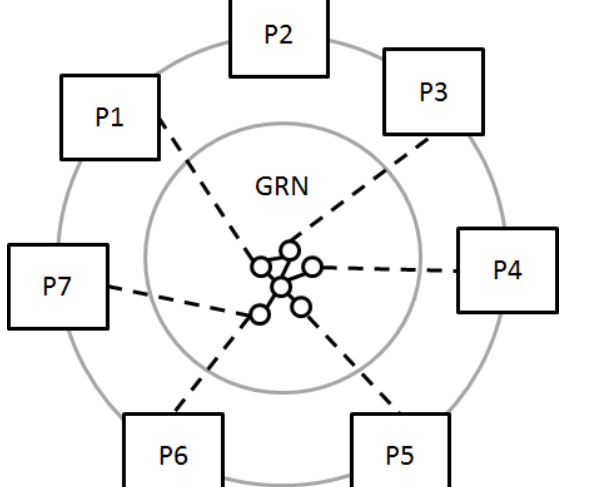
Figure 4: The result of the inter-network visualizer with the gene regulatory network in the center surrounded on a circle by pathways. The dotted edges show the connections between elements of both